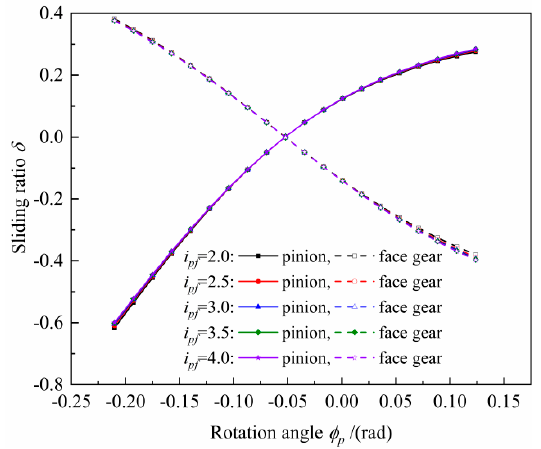
Figure 11. Effect of gear ratio i pf on sliding ratio.